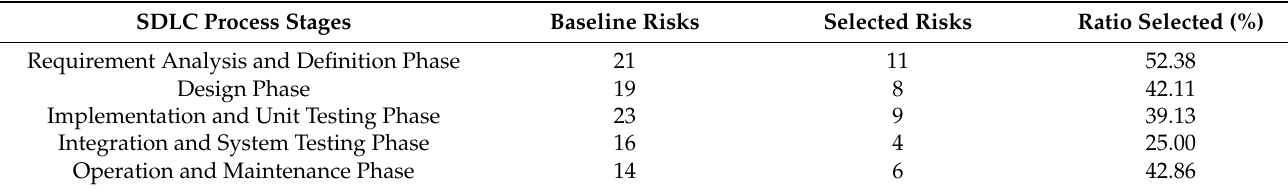
Table 6. Distribution of high priority risk factors